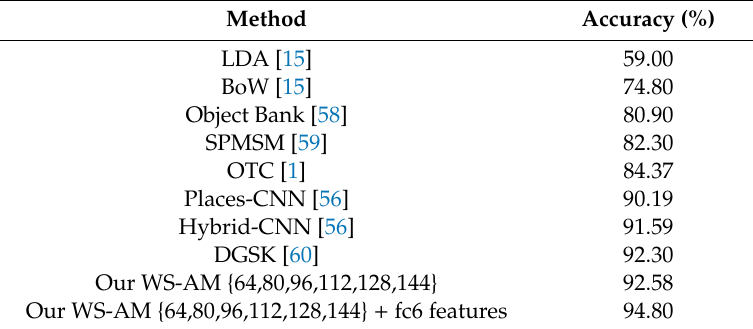
Table 3. Accuracy comparison on Scene 15